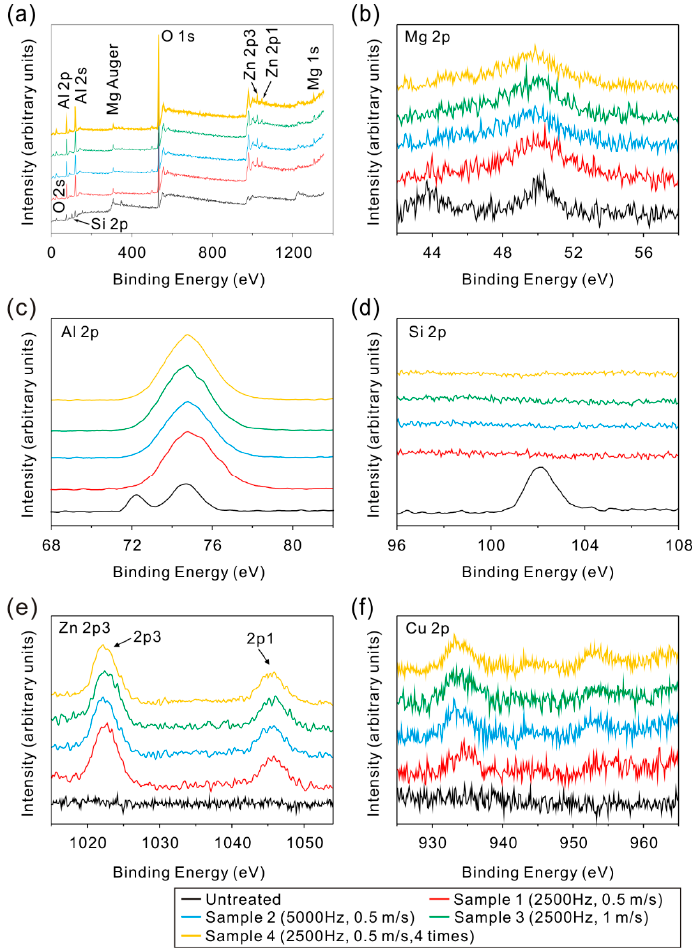
Figure 15. XPS spectra of the microstructure surface prepared by laser micro-engraving: ( a ) survey; ( b ) Mg 2p; ( c ) Al 2p; ( d ) Si 2p; ( e ) Zn 2p3; ( f ) Cu 2p. Table 2. Element contents of the microstructure surface calculated from XPS survey spectra.